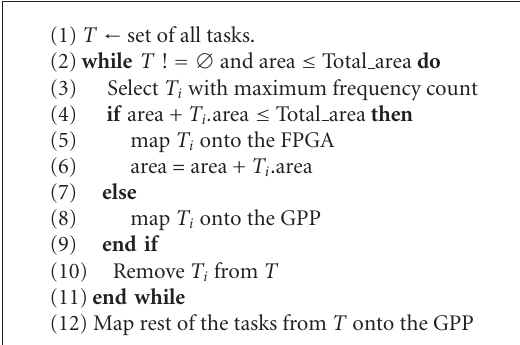
Algorithm 1: Pseudocode for the As Much As Possible heuristic (AMAP) for mapping task T i .